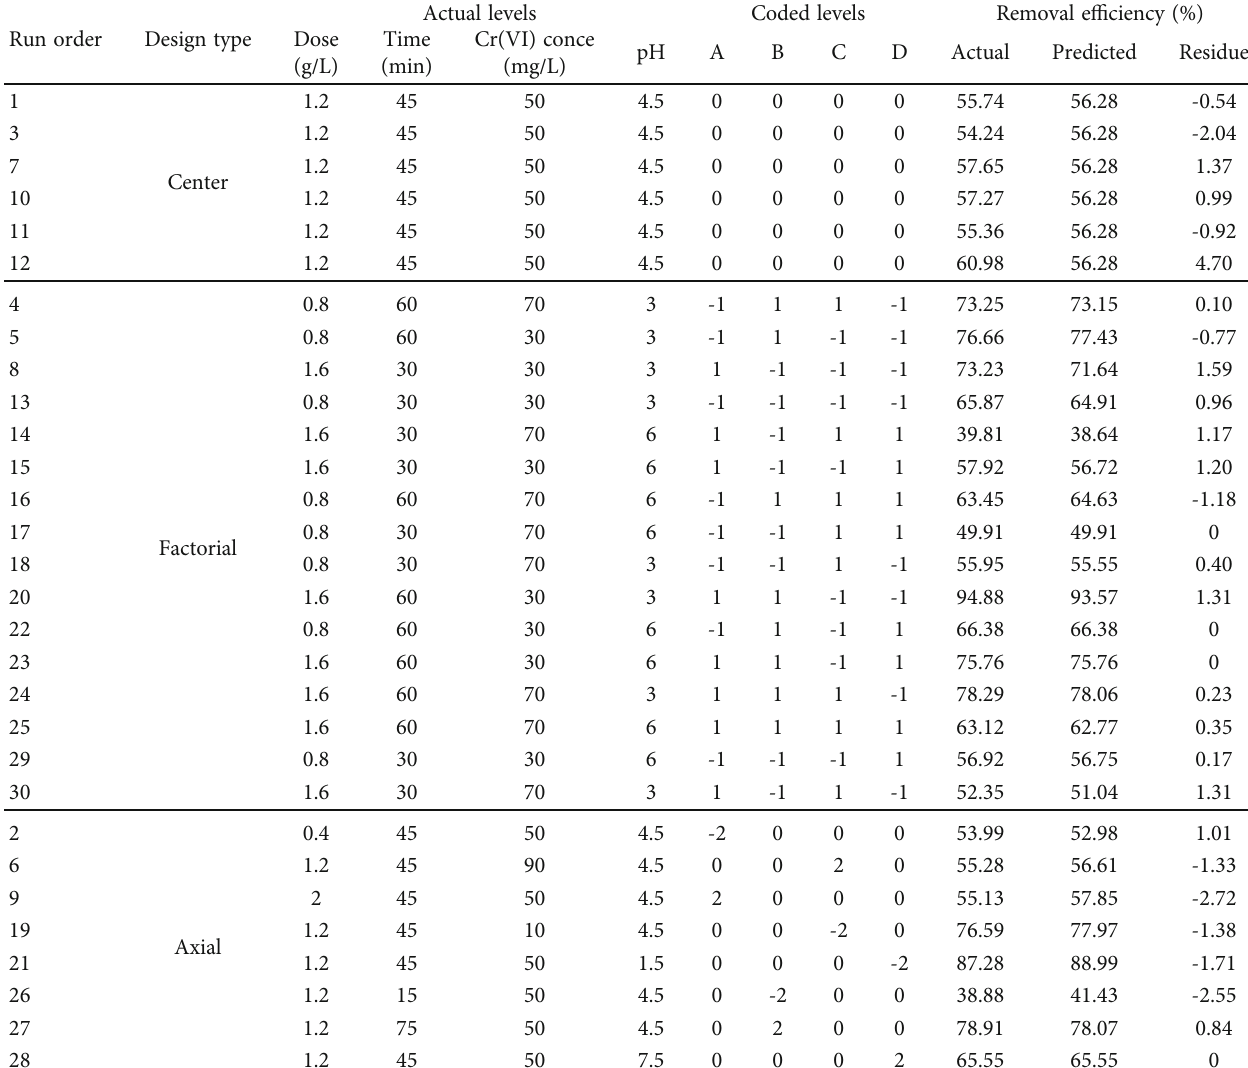
Table 5: CCD based experimental design (actual and coded levels) and responses (removal e ffi